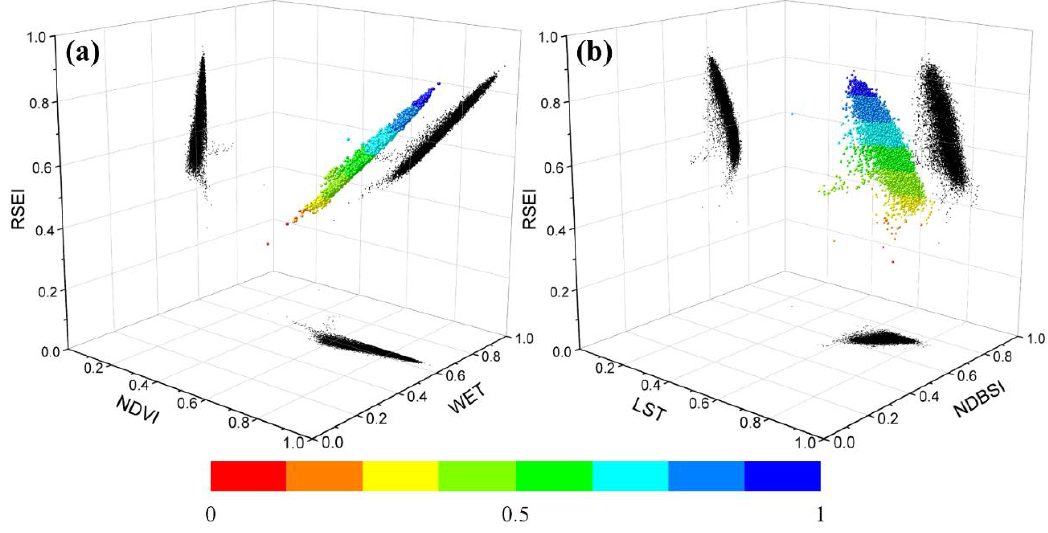
Figure 5. 3-D Scatterplot illustrate the relationships between WET, NDVI, LST, NDBSI, and RSEI. ( a ) The relationship among RSEI, NDVI and WET; ( b ) The relationship among RSEI, NDBSI, and LST.